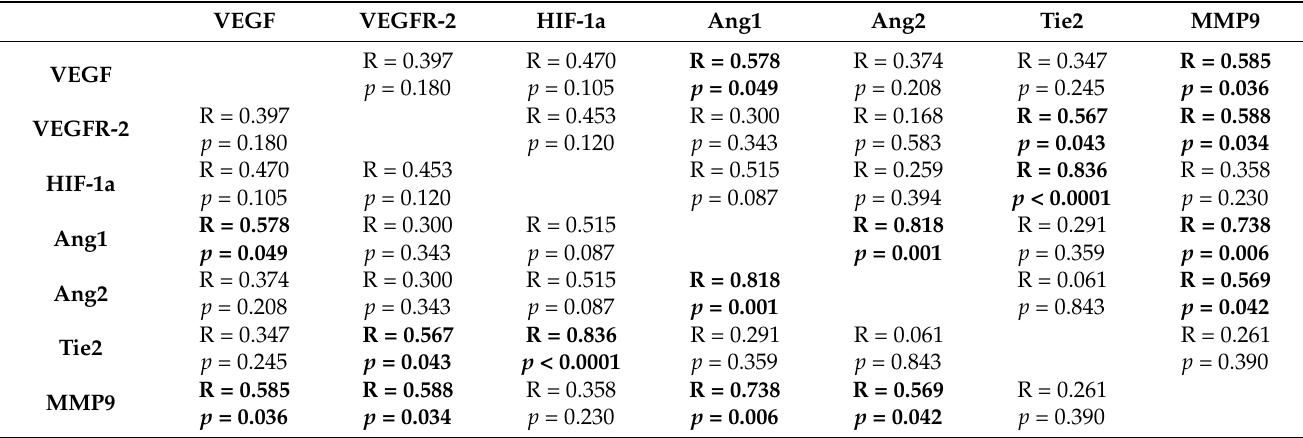
Table 4. Associations between the fold changes of angiogenic factors expression in the trained muscles of the patients with HF. Pearson correlation coefficient (R) and p -values are reported. Significant correlations ( p < 0.05) are highlighted in